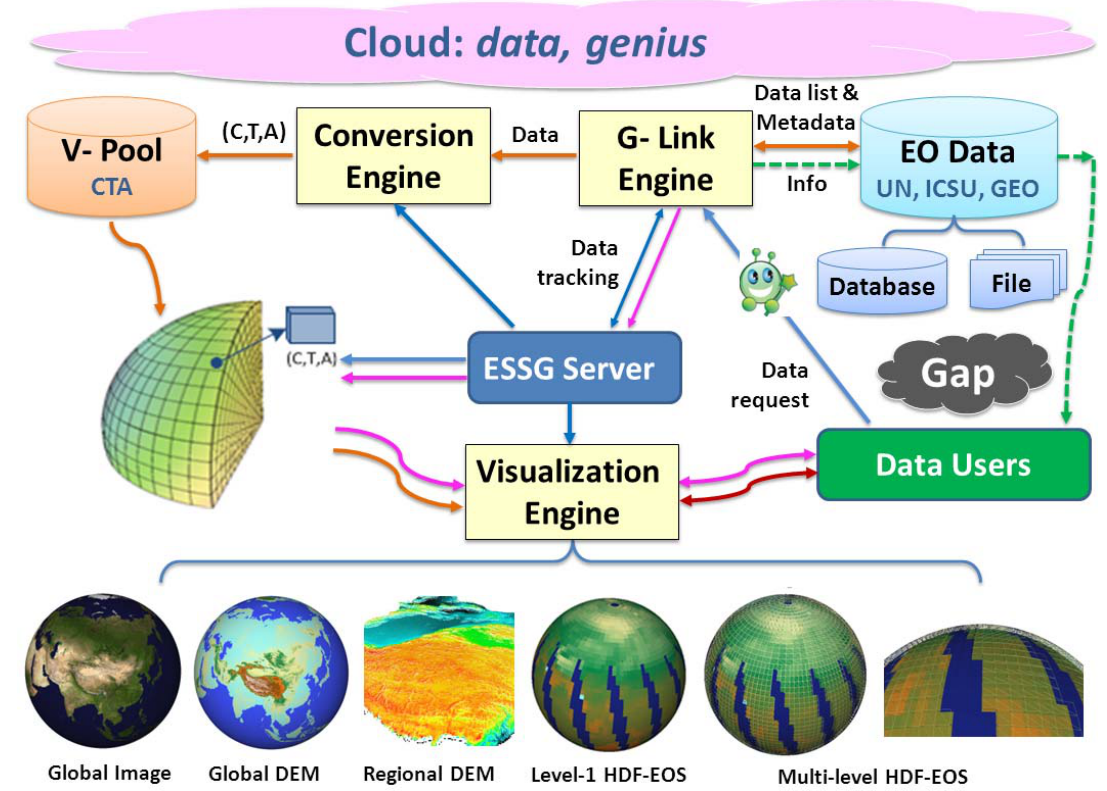
Figure 4. ESSG-based CTA organization and cloud-based access to big data on the planet